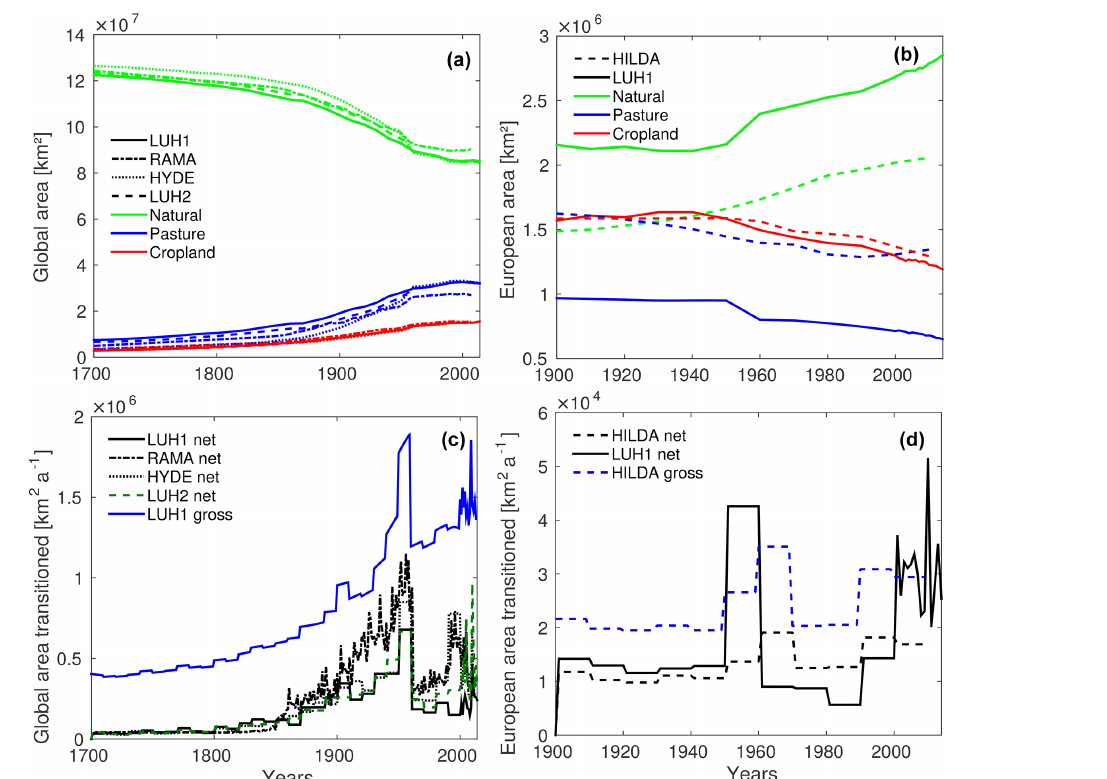
Figure 1. Land-use types and transitions in global and European (EU27 + CH) LUC reconstructions. The evolution of absolute land area of croplands, pastures and natural vegetation (including barren land) in different (a) global historical land-use reconstructions (LUH1: solid line; RAMA: dash-dotted line; HYDE: dotted line; LUH2: dashed line) and (b) European land-use reconstructions (HILDA: dashed line; LUH1: solid line). Land area experiencing gross and net land transitions on a global scale (c) and for Europe (d) . Note the change to annual resolution in the LUH1 reconstruction after the year